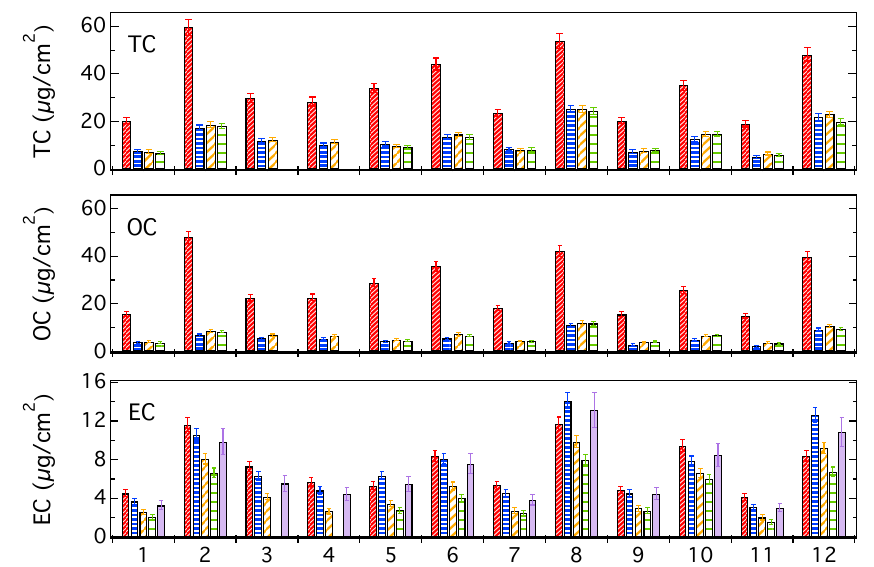
Figure A1. TC, OC and EC concentrations determined with the EUSAAR_2 protocol on untreated (EUSAAR_2) and water-extracted (EUSAAR_2 WE) filter samples and determined with the 2stepCIO protocol on the Sunset analyzer with an intermediate step (450 ◦ C) of 2 min (2stepCIO (Sunset) 2min) and 3min (2stepCIO (Sunset) 3min) and the 2stepCIO protocol on the ACS (2stepCIO (ACS) 2min) for all investigated filter.